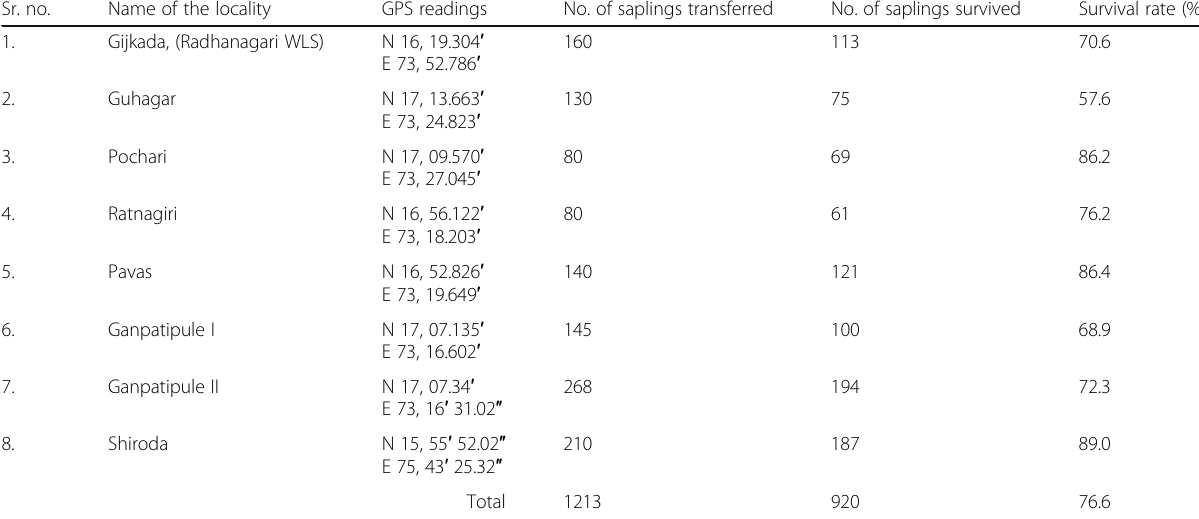
Table 2 Reintroduction profile of micropropagated plantlets of C. mohanramii at different localities of the Western Ghats Sr.